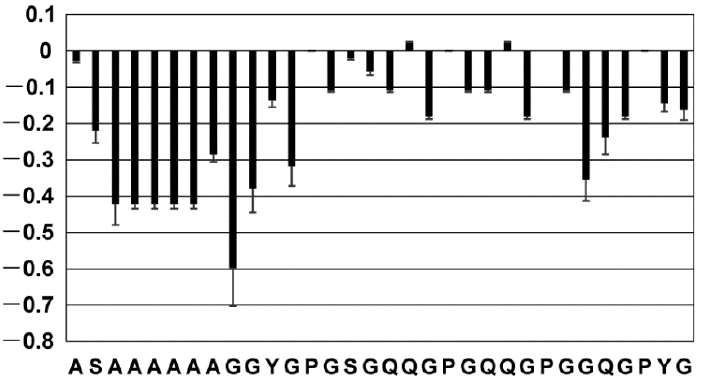
Figure 5 . 15 N-{ 1 H} steady-state NOE for each residue in the 32-residue repetitive sequence of